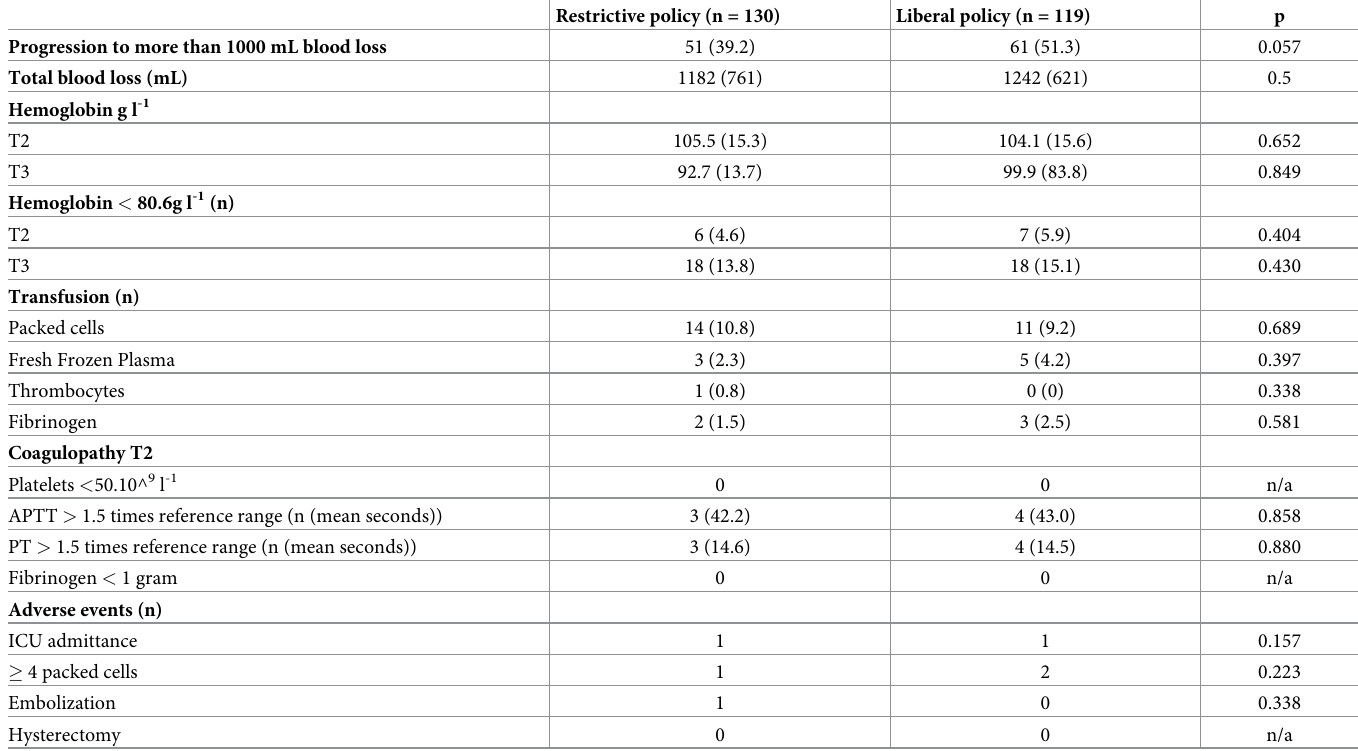
Table 2. Primary and secondary outcomes.